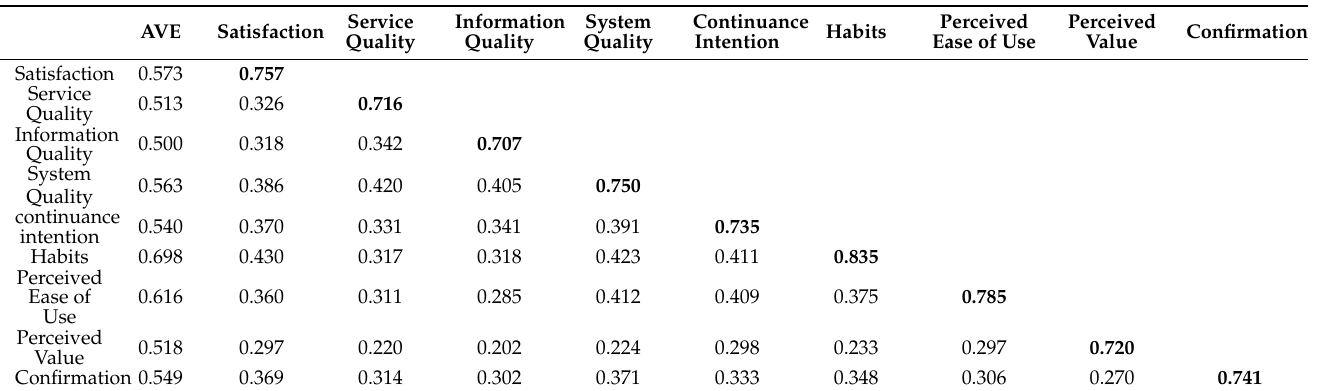
Table 3. Discriminant validity for the measurement model.